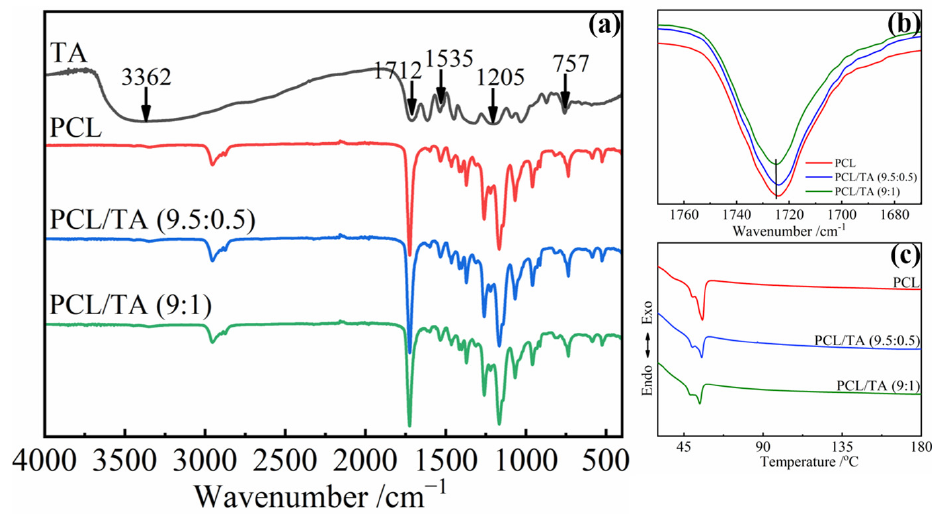
Figure 2. FTIR spectra ( a , b ) and DSC curves ( c ) of electrospun nanofiber scaffolds spun from pure PCL and from solutions with different PCL/TA weight ratios (9.5:0.5 and 9:1).